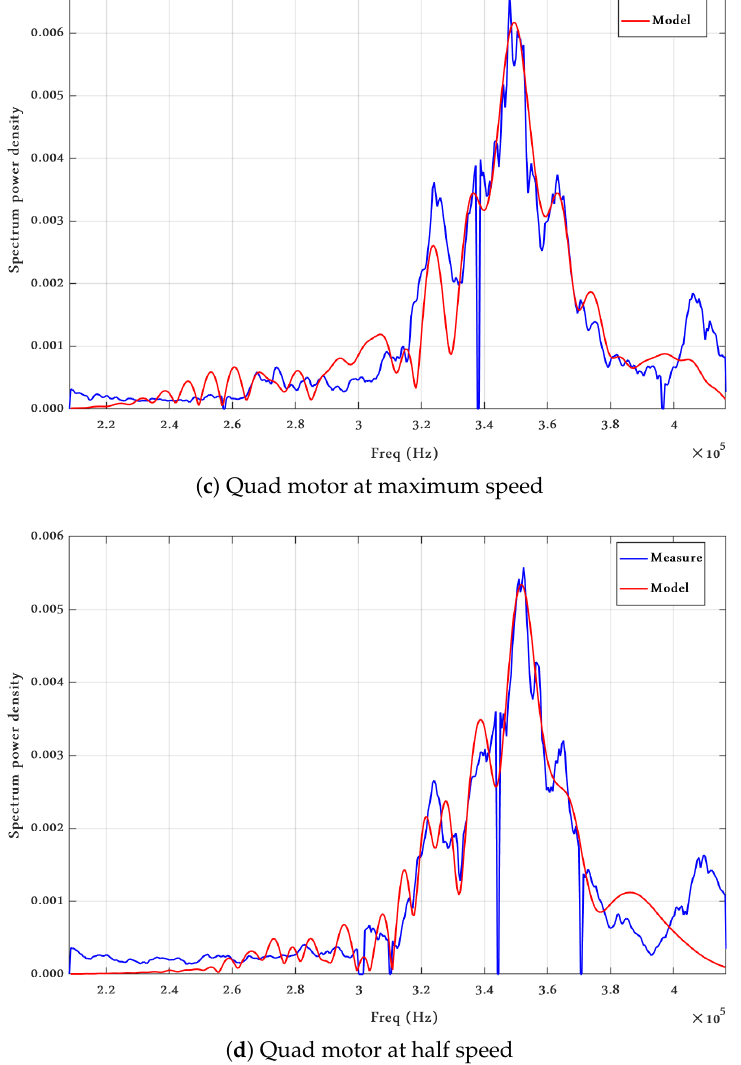
Figure 5. The fitting paradigm of the genetic algorithm between the output FMCW radar mea- surements and the simulated FMCW radar measurements applying the UAV vibrational model for different UAV state